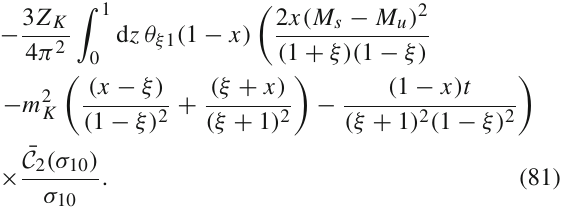
(cid:3) (cid:2) u quark TMD of the kaon; and right panel – k 2 ⊥ f x , k 2 ⊥